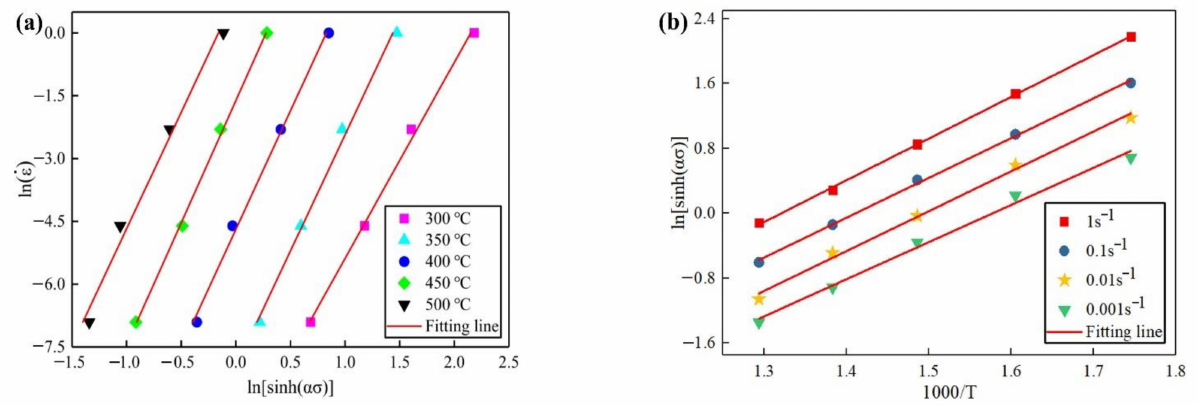
. ε and 1/ T with ε = 0.6: ( a ) the relation between